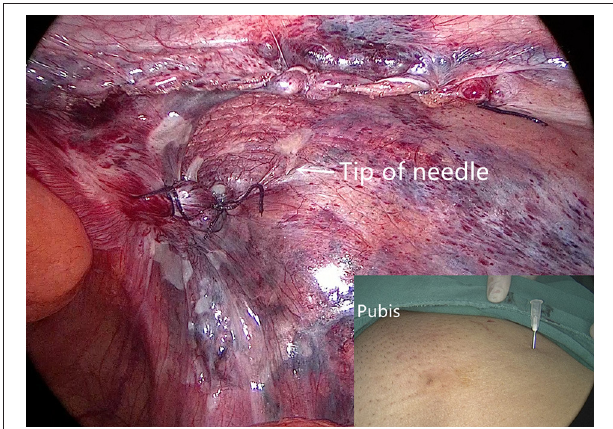
FIGURE 8 | Seroma-related published literature